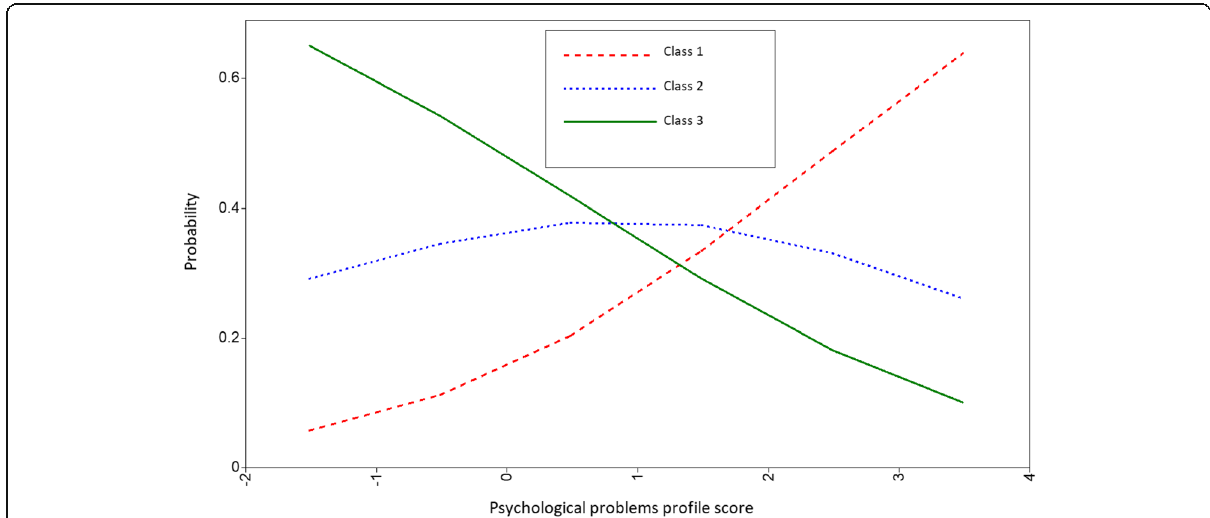
Fig. 2 Probability of membership in identified classes of MSDs as a function of psychological problems scores. Class 1, high rate of MSDs in neck, shoulder, and joints (dashed line). Class 2, high rate of MSDs in upper and lower back (dotted line). Class 3, low MSDs prevalence in all sites (solid